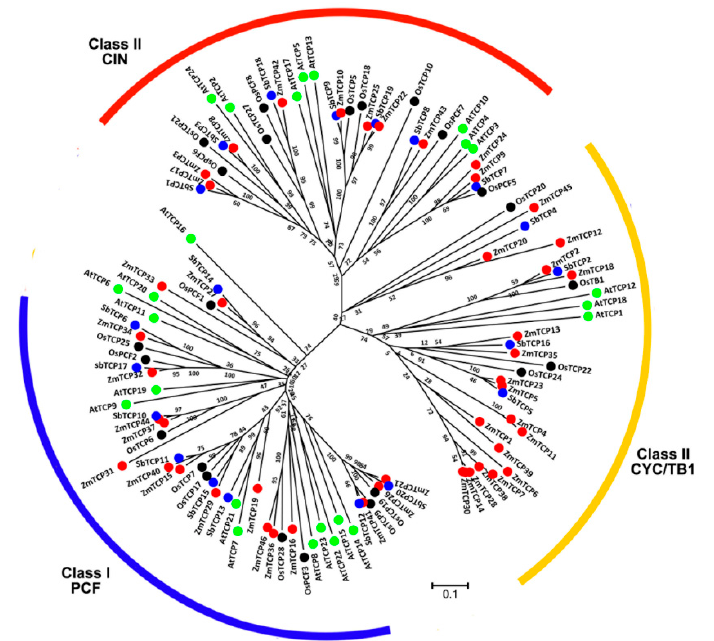
Figure 1. Phylogenetic tree of the predicted Teosinte-branched 1 / Cycloidea / Proliferating (TCP)proteins frommaize, rice, sorghum, and Arabidopsis . Thephylogenetictreewasconstructedbasedonthesequence alignment of the 113 full-length TCP protein sequences from four species. The unrooted tree was drawn by MEGA 7.0 with the neighbor-joining (NJ)method, using the following parameters—bootstrap values (1000 replicates)and the poisson model. The scale refers to the branch lengths. The gene codes and names are illustrated in red for maize, black for rice, blue for sorghum, and green for Arabidopsis . The names used for rice and the Arabidopsis TCP genes are from a previous report